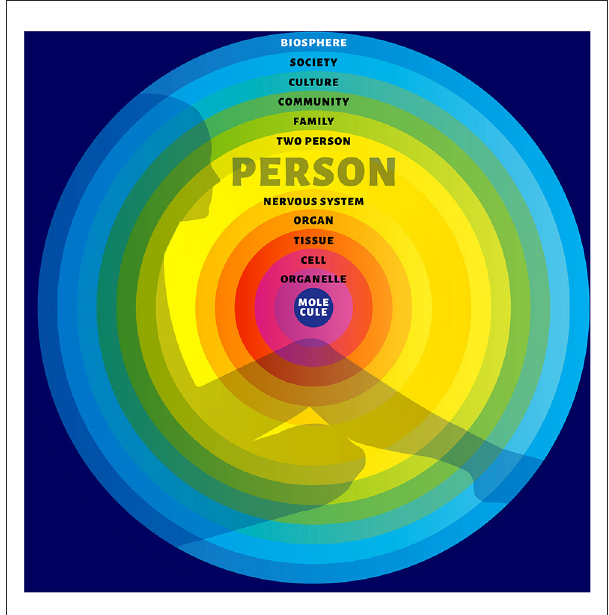
FIGURE1 Biopsychosocial human-environment